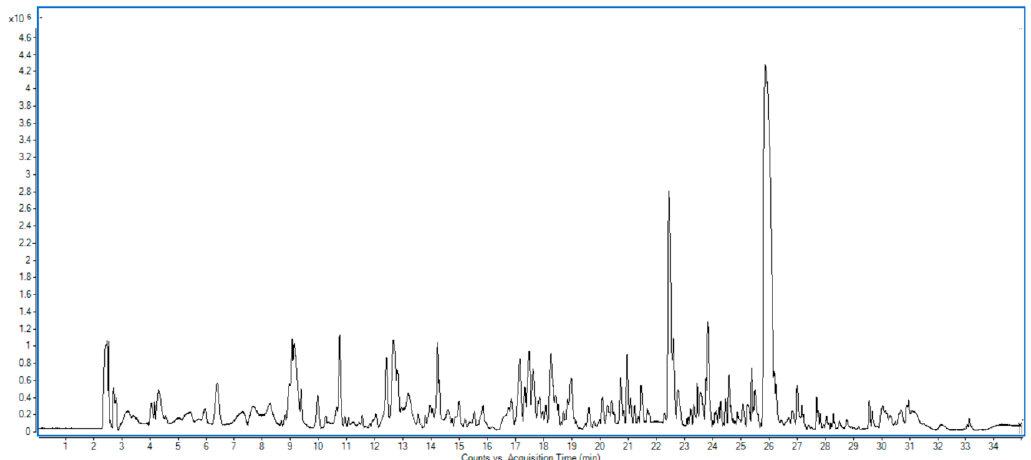
Figure 1. Base peak chromatogram of the cake of the Egyptian cultivar of sesame ‘Giza 32’.